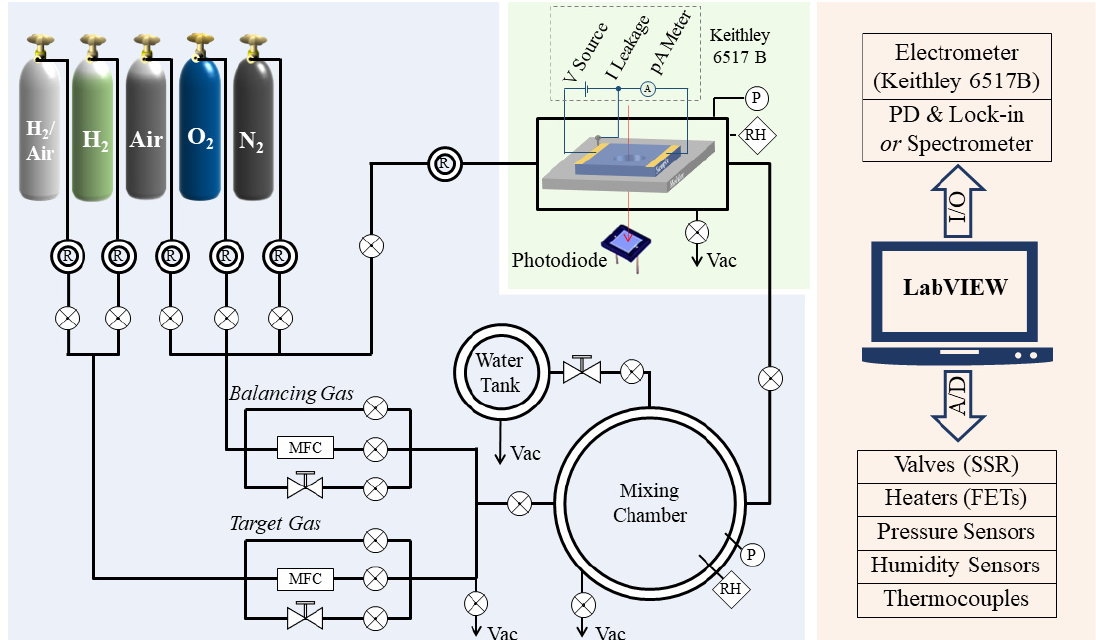
Figure 1. Schematic diagram of gas sensing material characterization system.